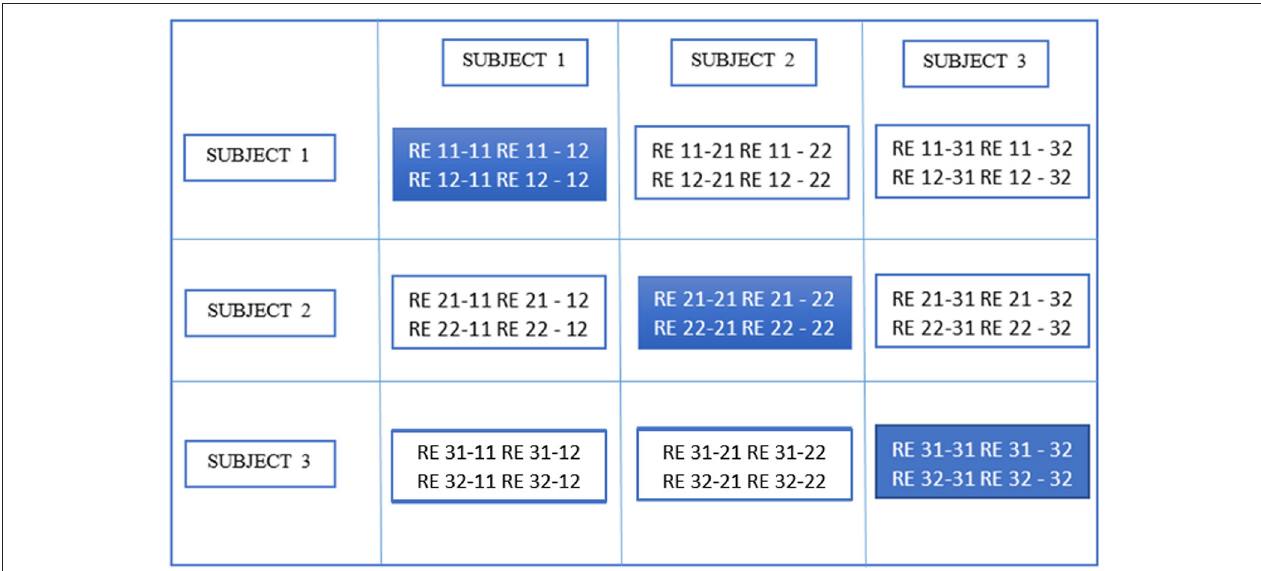
FIGURE 4 | Block structure of full similarity matrix ( FSM ) based upon our example with 3 subjects and 2 sets of subject-level components (RE, a set of ICs produced after two ICA decompositions). In this example, each block shows similarity between 2 pairs of REs from the same subject or two different subjects. Also, RE 11-31 indicates inter-subject similarity between RE 1 of subject 1 and RE 1 of subject 3. The first digit in 11 is an index to the subject whereas the second is an index to the RE. Solid colored, on the diagonal blocks indicate similarity within the components of a subject or intra-subject similarity whereas off diagonal ones indicate that between the components of two different